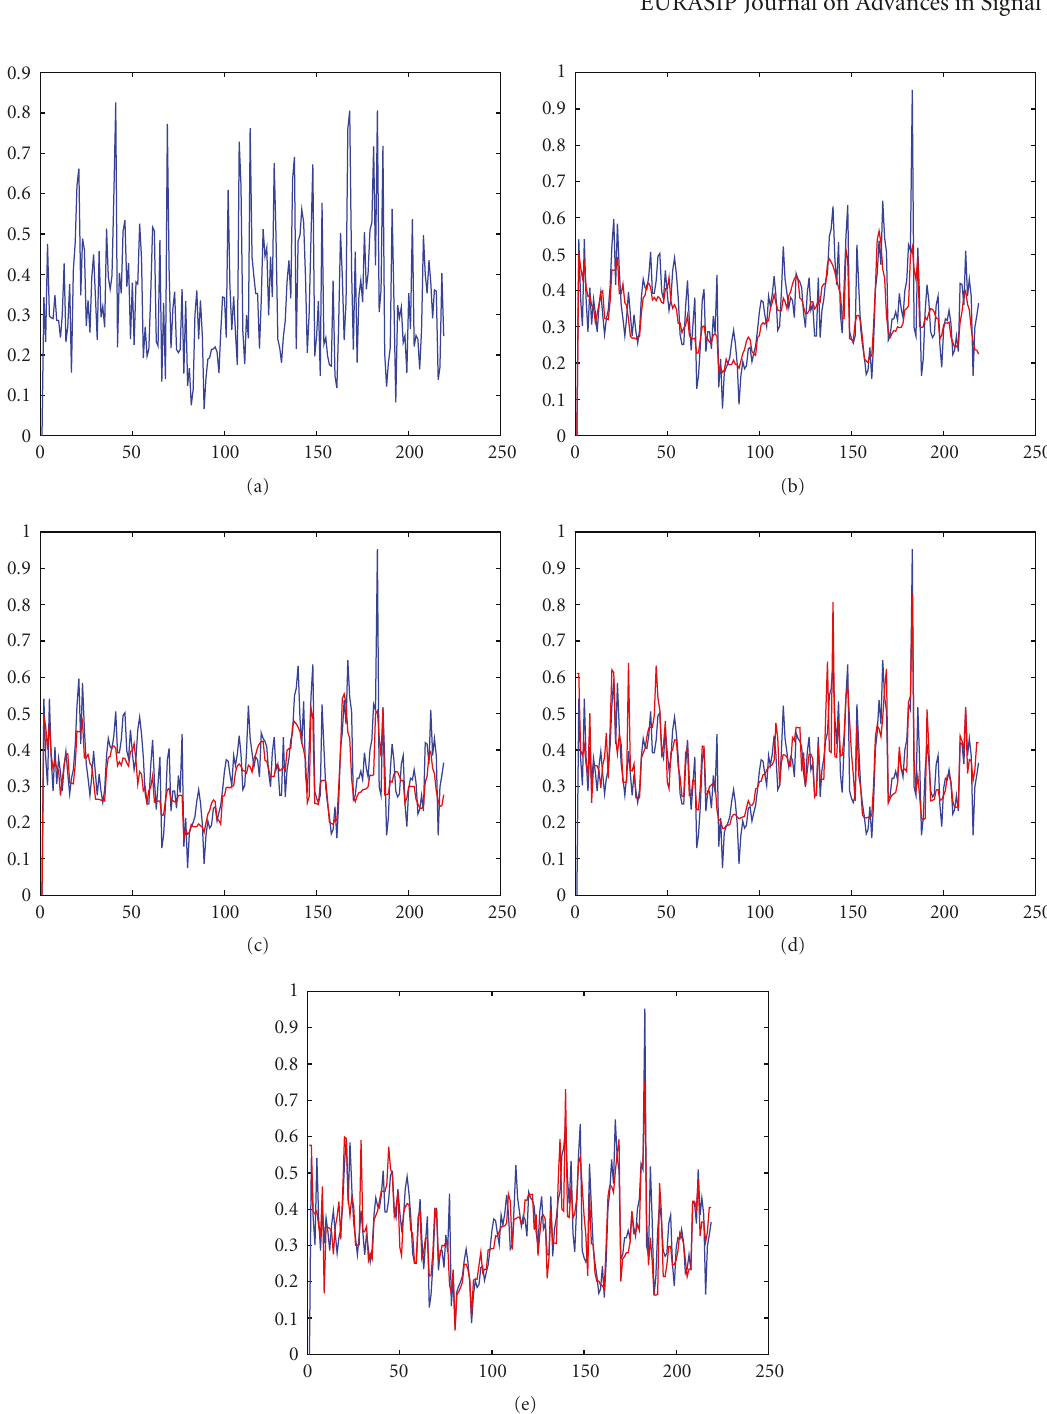
corrupted by a Gamma noise with L = 2, while Figure 3(b) shows the noisy SAR image which is distorted by Gamma noise with L =